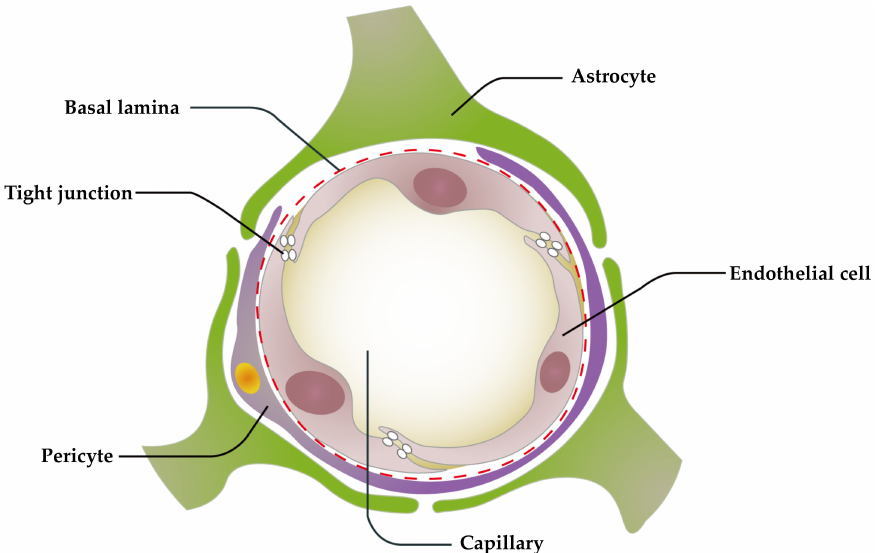
Figure 1. Blood brain barrier detailed anatomy showing capillary, tight junction, endothelial cell, pericyte, basal lamina, and